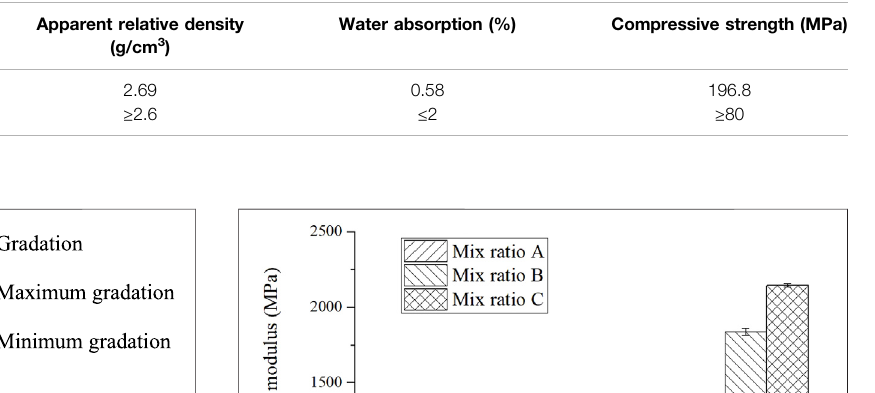
TABLE 3 | Crushed stone performance test.